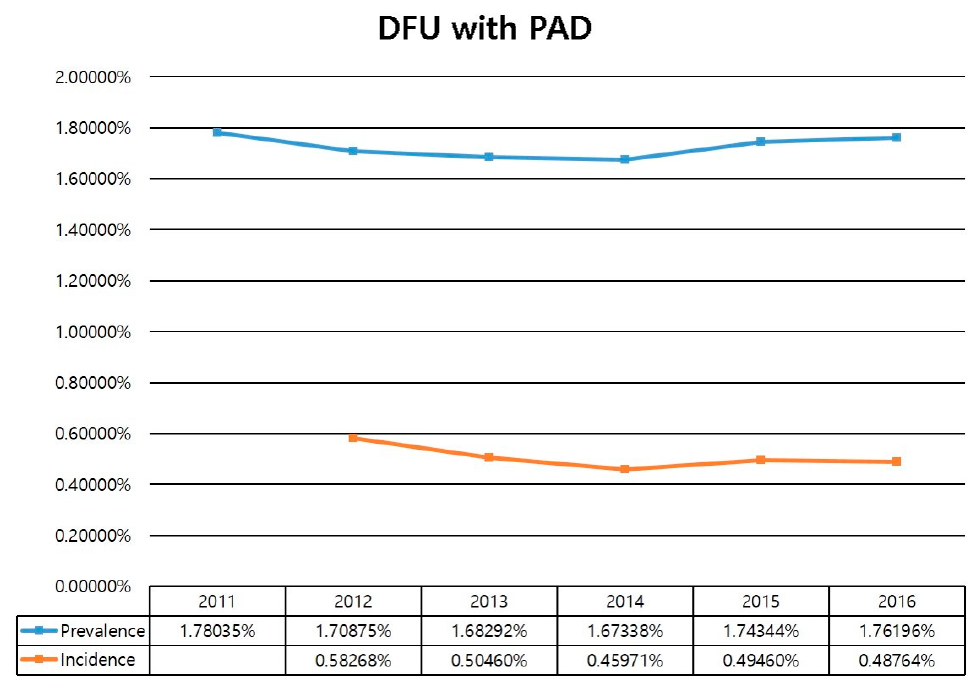
Figure 1. Annual the incidence and prevalence of diabetic foot ulcer with PAD.